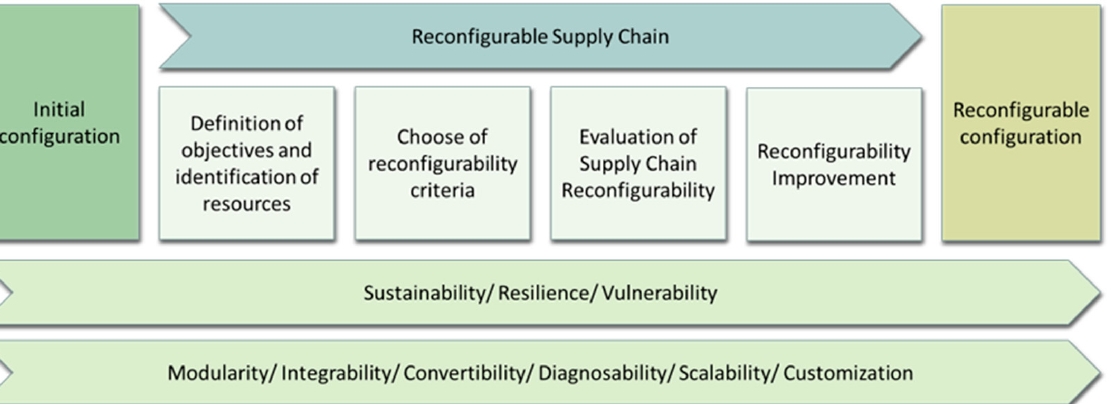
Figure 4. The proposed roadmap for the selection of the most reconfigurable supply chain configu-